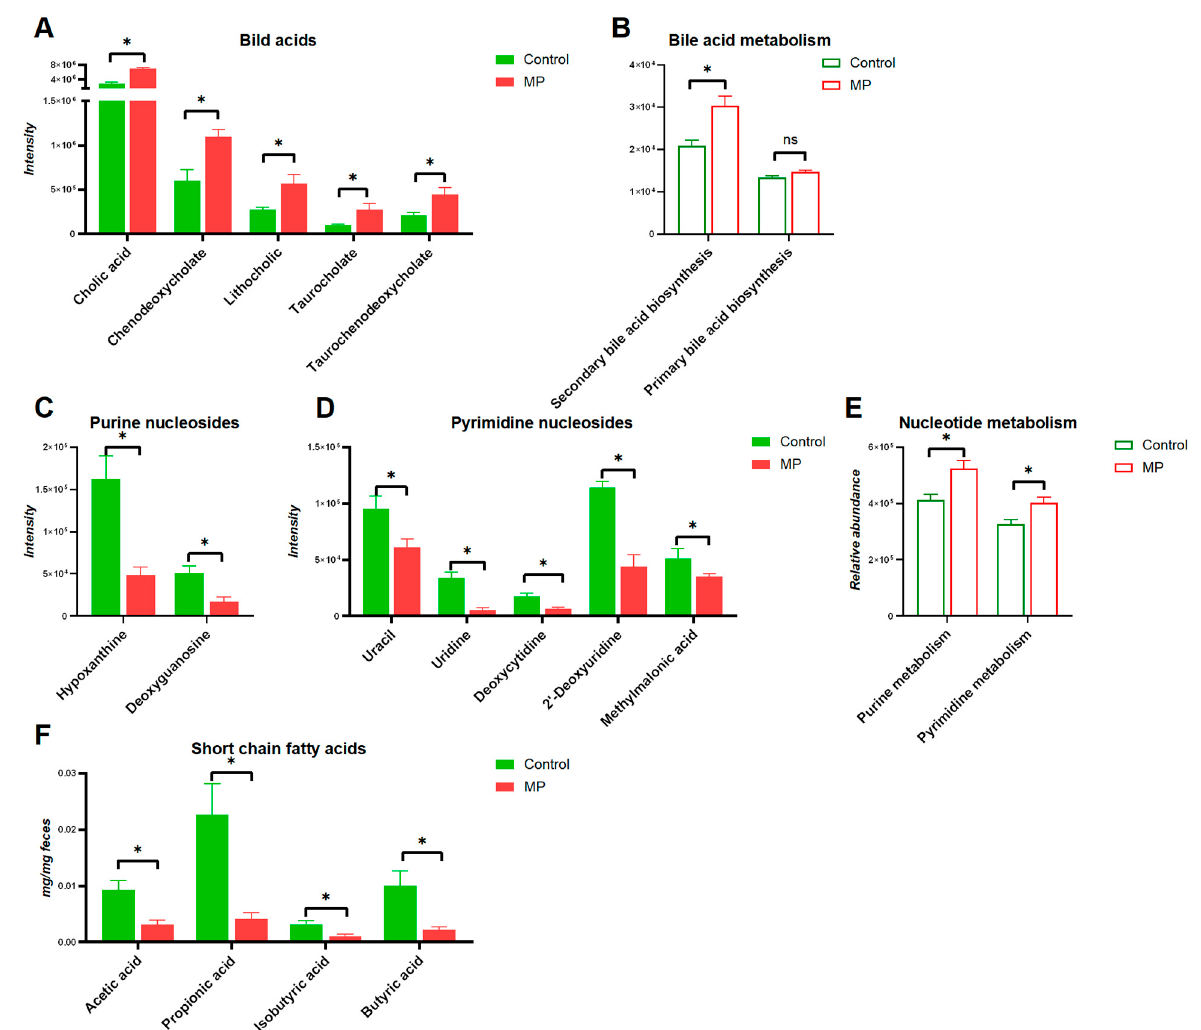
Figure 5. Key metabolites in the gut microbiota associated with MP exposure. ( A ) bile acids ( n = 6). ( B ) Pathways involved in bile acid metabolism ( n = 8). ( C ) Purine nucleosides ( n = 6). ( D ) Pyrimidine nucleosides ( n = 6). ( E ) Pathways involved in nucleotide metabolism ( n = 8). ( F ) Short-chain fatty acids ( n = 6). *, p < 0.05.